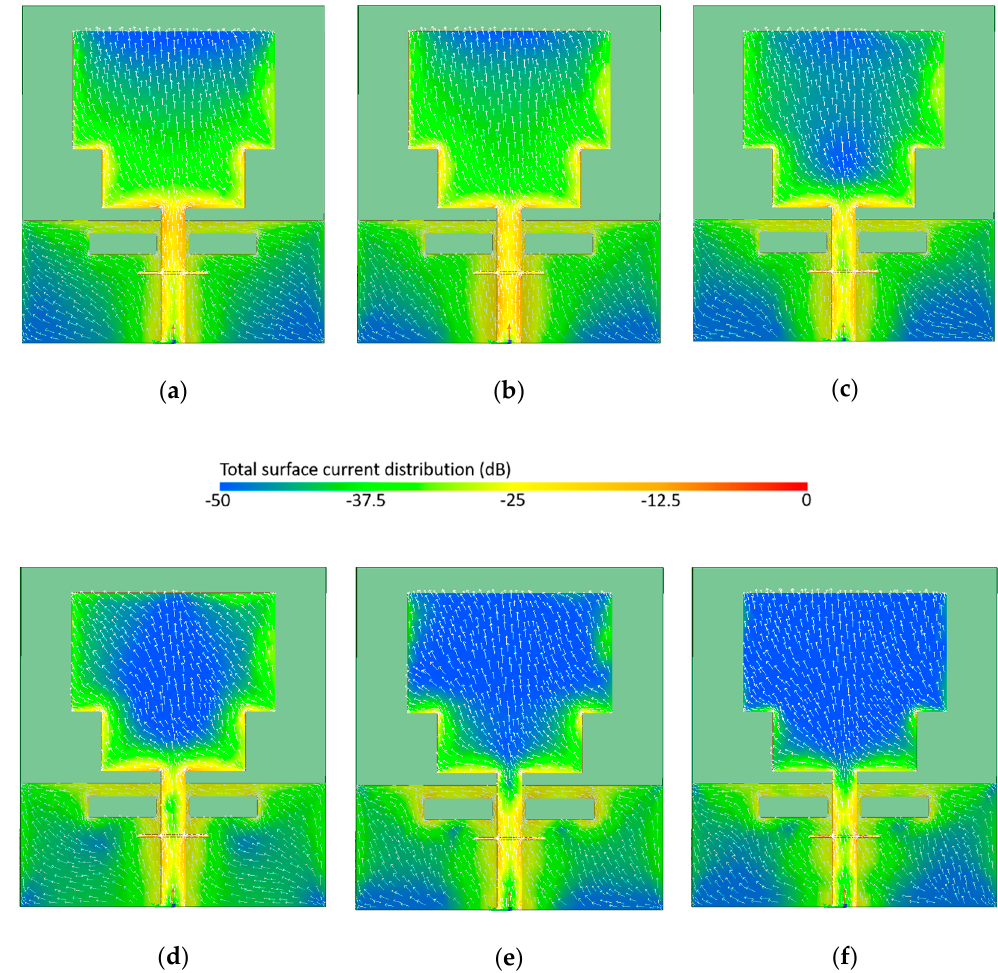
Figure 8. Simulated current density distribution in the antenna conductors at the most significant frequencies for the proposed antenna: ( a ) 3 GHz; ( b ) 4 GHz; ( c ) 6 GHz; ( d ) 8 GHz; ( e ) 10 GHz; ( f ) 11 GHz.